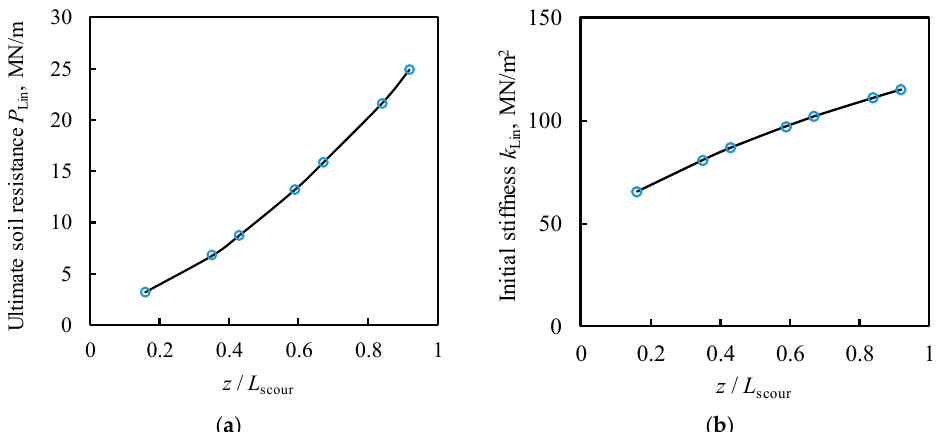
Figure 9. P and k values calculated from the ABAQUS numerical model: ( a ) Ultimate soil resistance, ( b ) Initial stiffness.